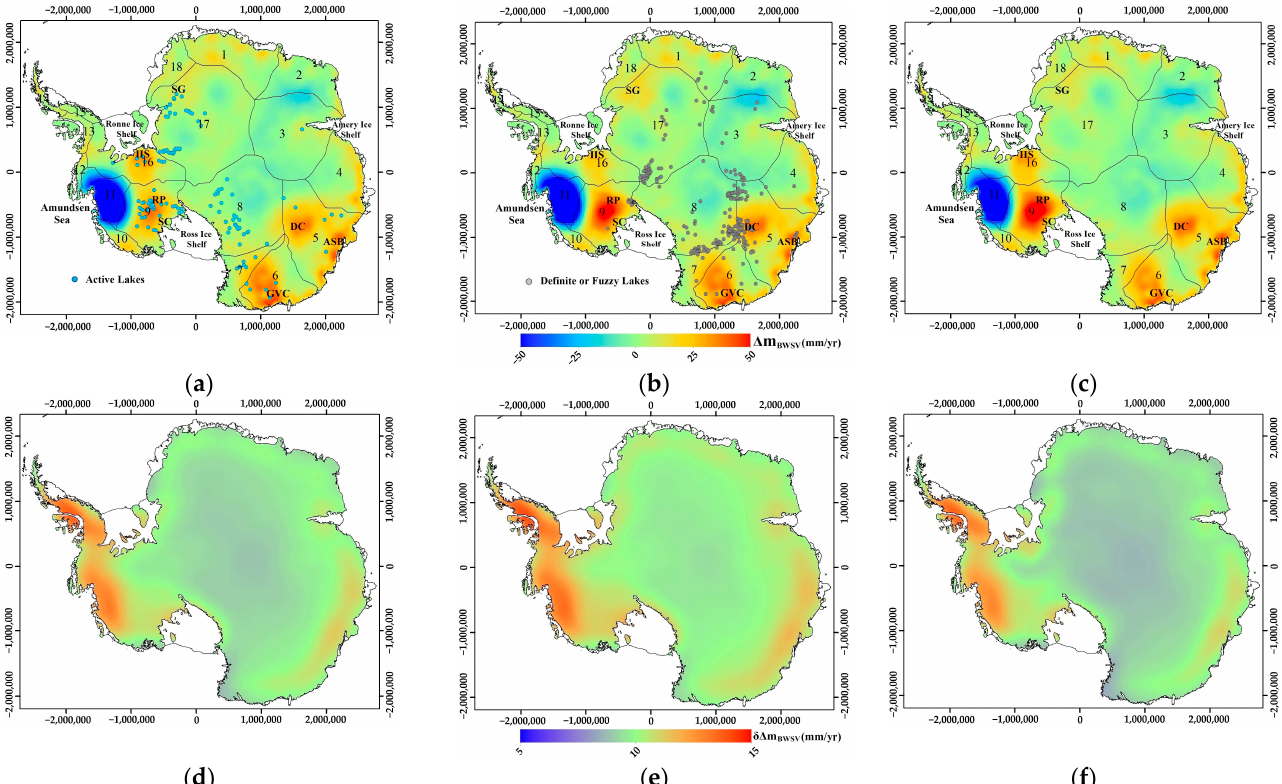
Figure 12. Spatial distribution of BWSV related to ( a ) ICE-6G, ( b ) IJ05_R2 and ( c ) W12a, and ( d – f ) associated standard deviations (in mm/yr). Blue and grey dots in ( a , b ) represent active subglacial lakes and definite or fuzzy subglacial lakes, respectively. DC = Dome